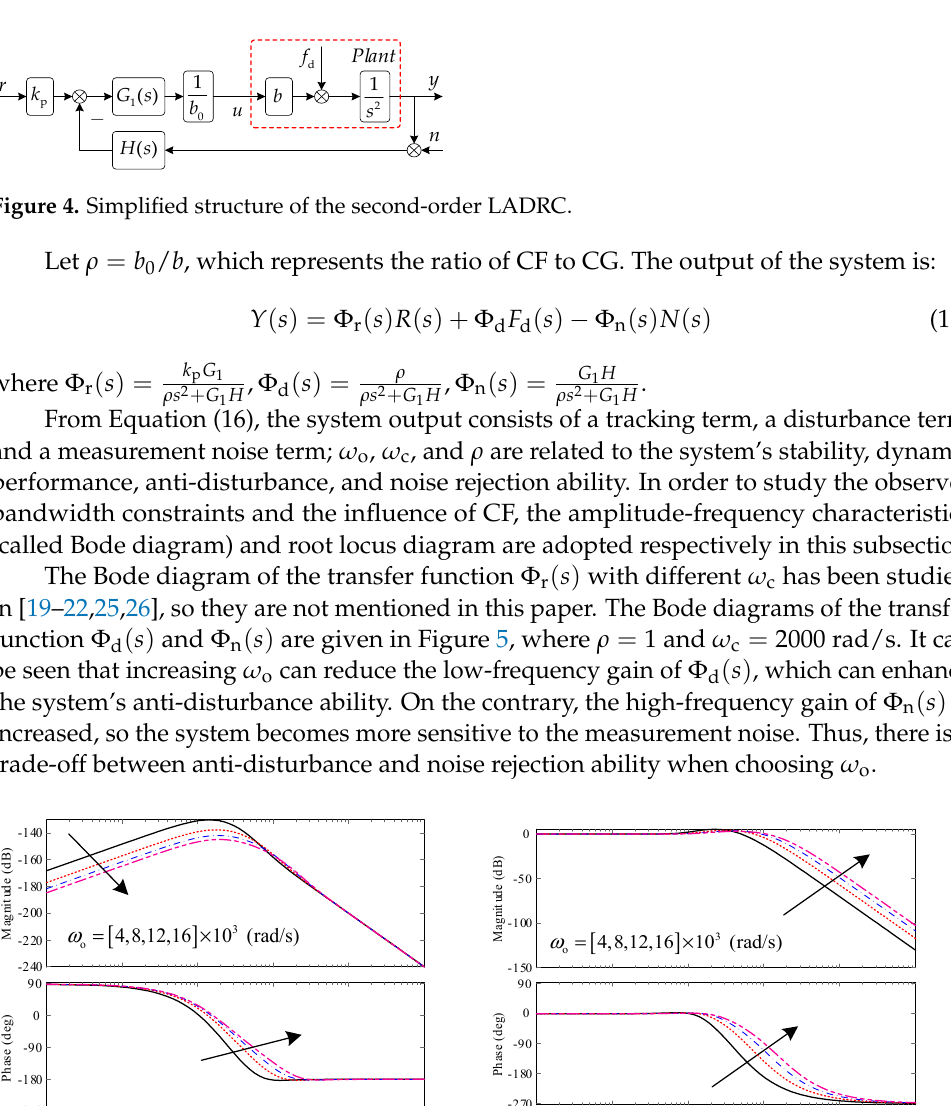
Figure 5. Bode diagrams with different ω o : ( a ) Disturbance term Φ d ( s ) ; ( b ) Noise term Φ n ( s ) .